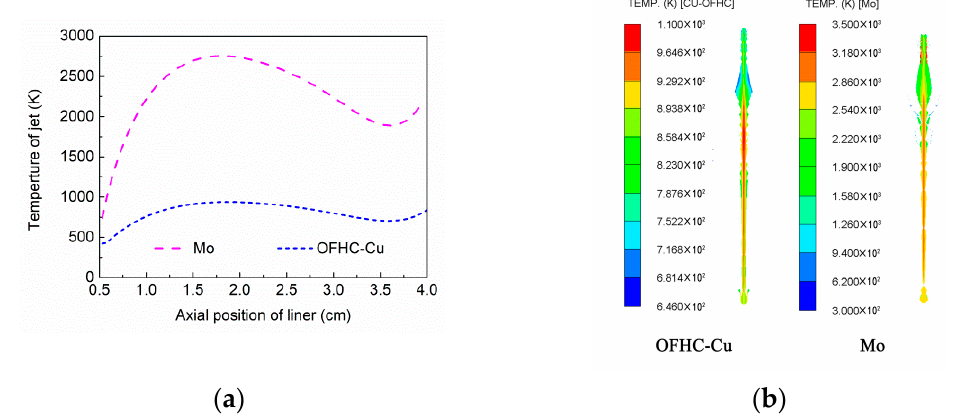
Figure 10. Temperature distribution of the OFHC-Cu and Mo jets (at 40 µs). ( a ) Theoretical predictions; ( b ) Numerical simulations. Table 4. Temperature distribution of the jets at 40 µs and data comparison.